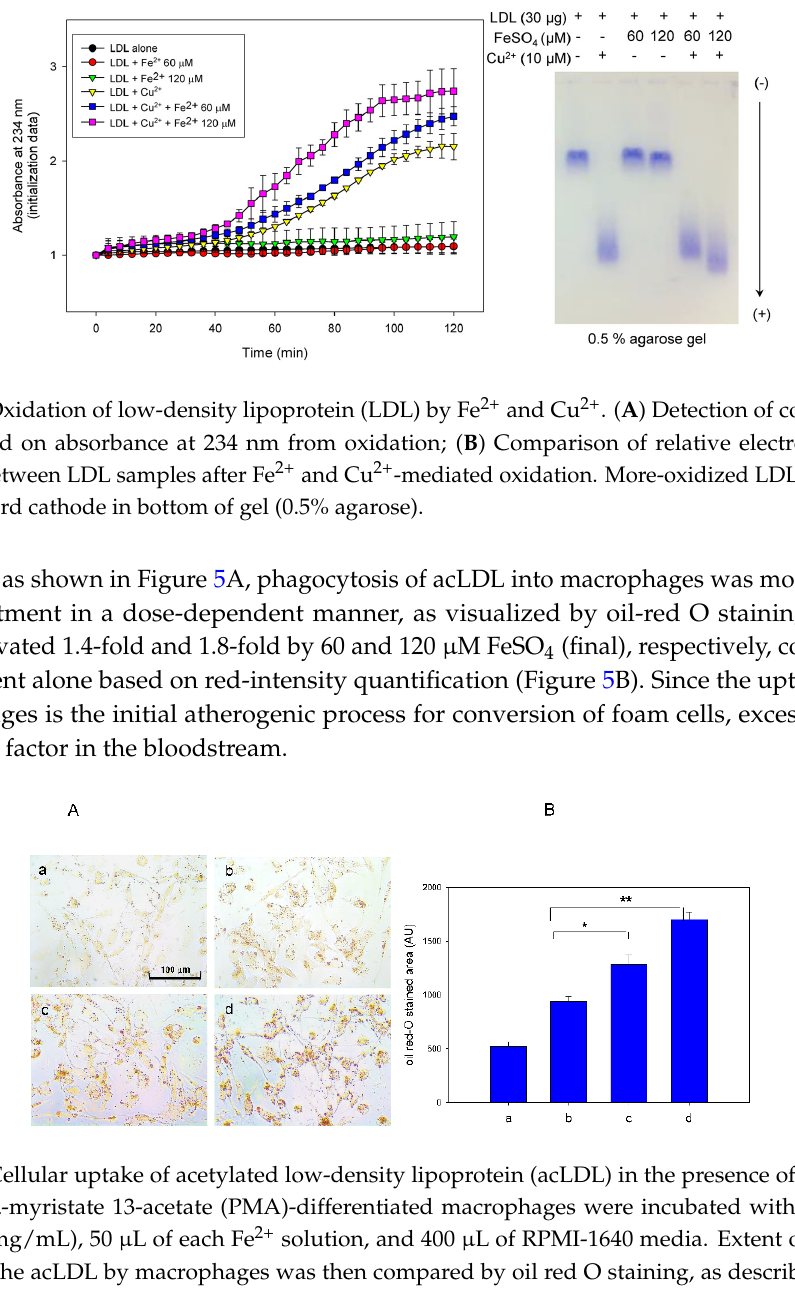
8 of 16 Figure 3. Treatment with Fe 2+ to apoA ‐ I with or without fructose for induction of glycation. ( A ) Production of glycated end products based on detection of fluorescence (Ex = 370 nm, Em = 440 nm);